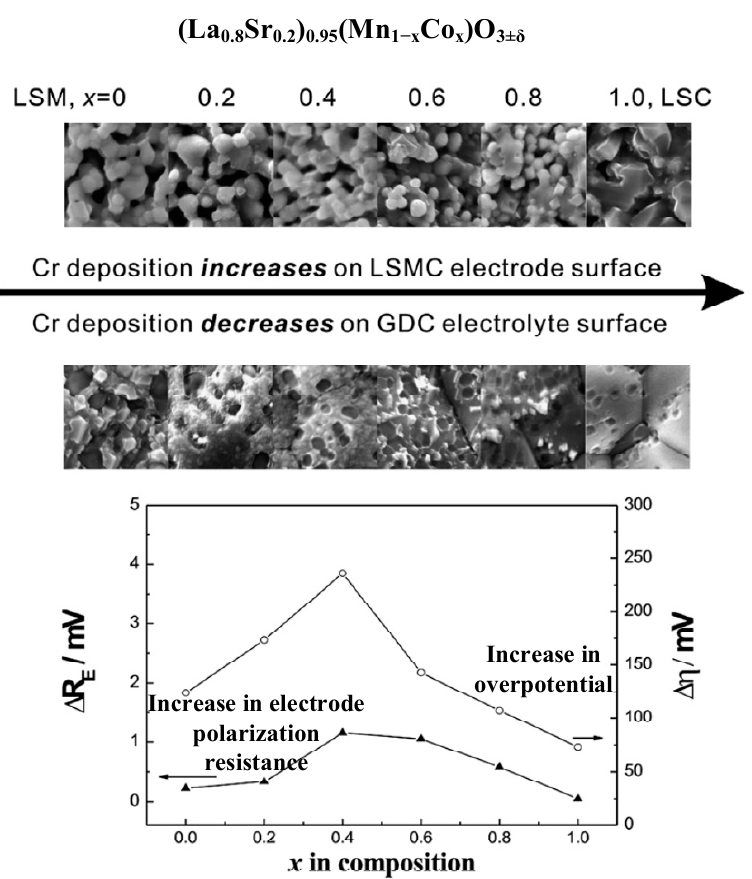
Figure 4. Effect of Co content on Cr poisoning. Adapted with permission from Ref. [16].